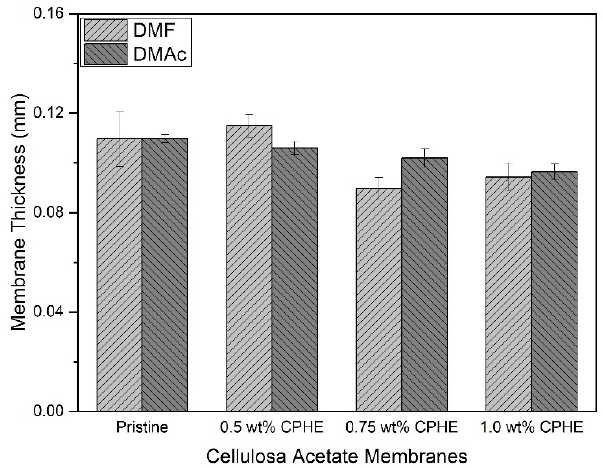
Figure 3. Average membrane thickness with different membrane